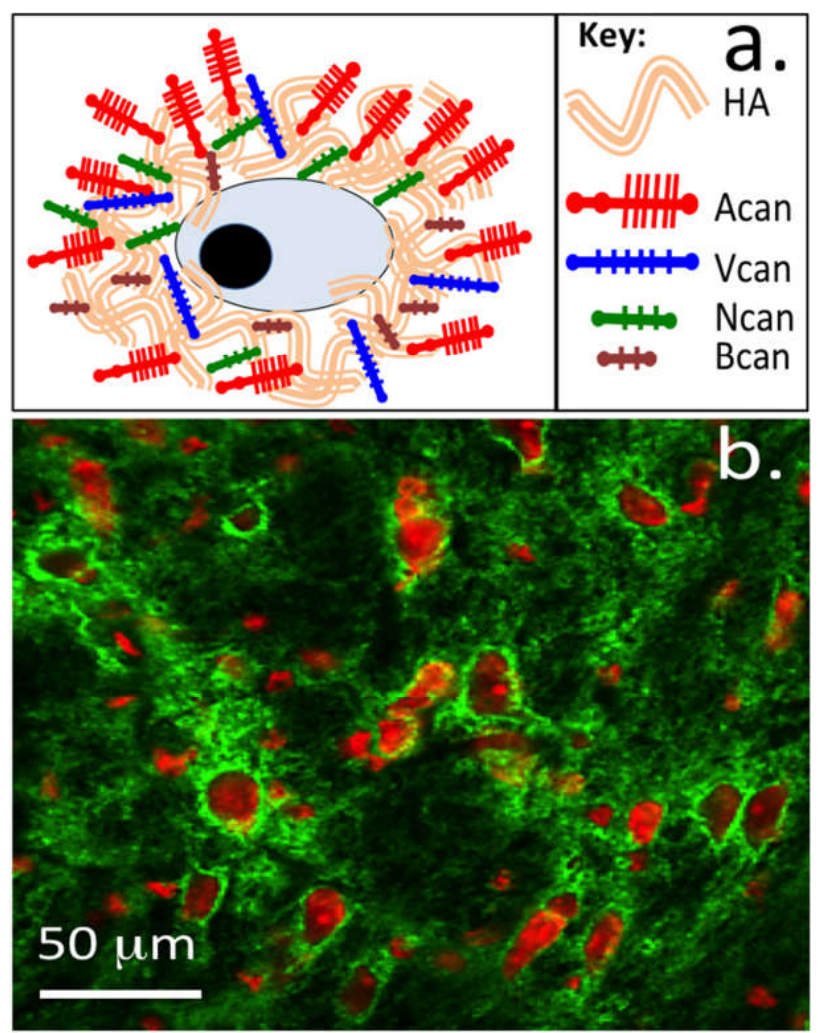
Figure 3. Schematic of aperineuronal net structure showing the interaction of hyaluronan (HA) with members of the lectican proteoglycan family, aggrecan (Acan), versican (Vcan), Brevican (Bcan) and neurocan (Ncan) showing the dense matrix around neurons termed perineural nets (PNNs) ( a ). The 1-B-6 (+) proteoglycan immunolocalizations shown in ( b ) depicting perineuronal nets are modified with permission from [56] and [47] , © Caterson and Hayes 2002..